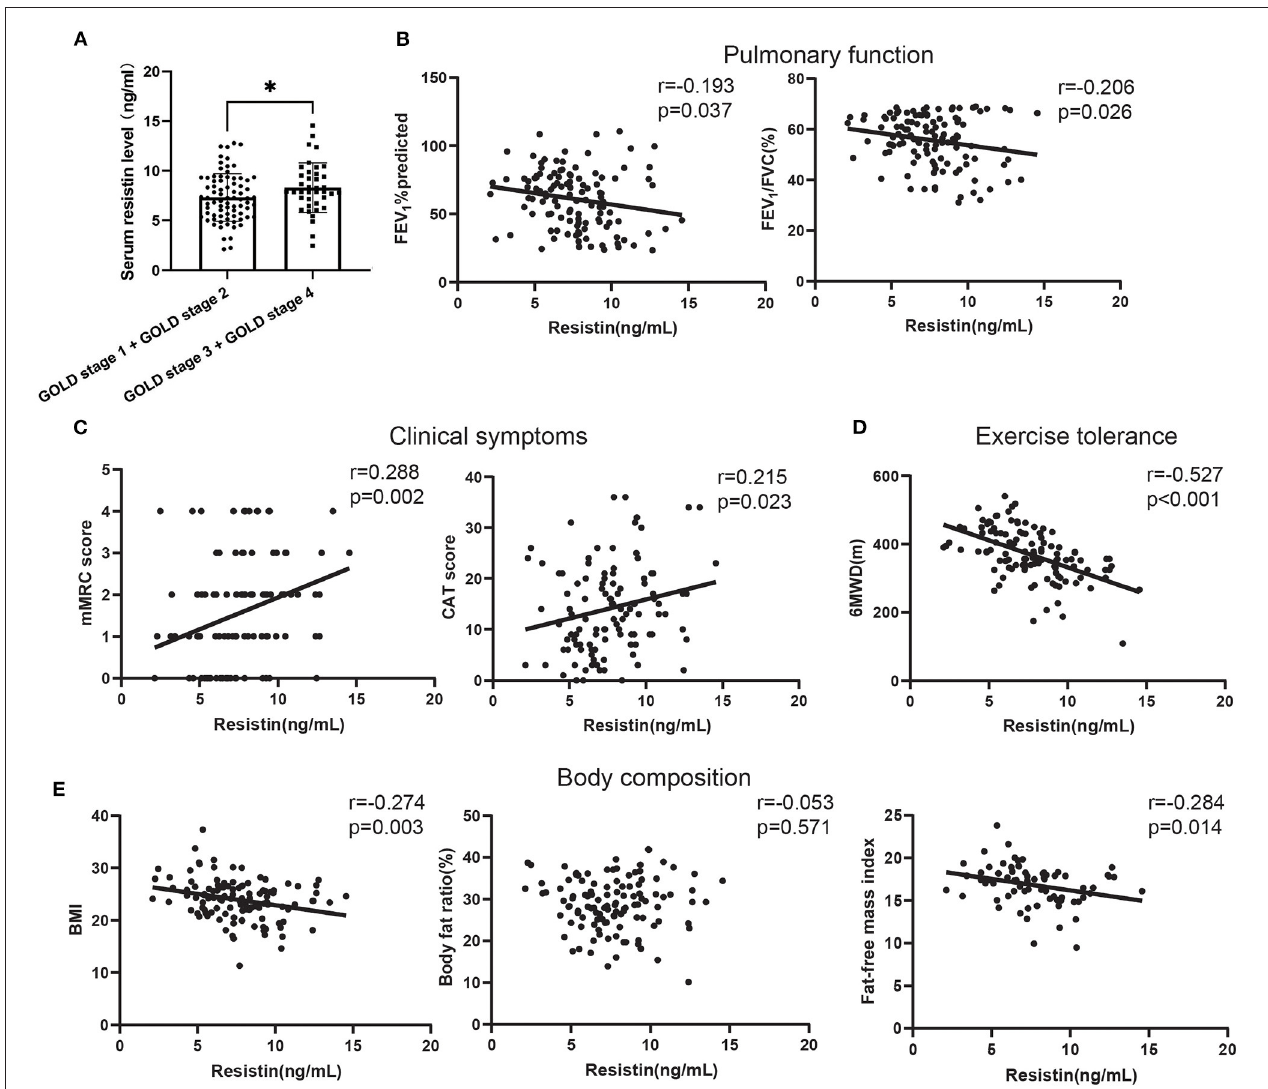
FIGURE 1 | The relationships of serum resistin levels with the clinical features of patients with COPD. (A) Difference in serum resistin level in patients with global initiative for chronic obstructive lung disease (GOLD) A and GOLD B and in patients with GOLD C and GOLD D; (B) The relationship between serum resistin level and FEV 1 %predicted, FEV 1 /FVC; (C) The relationship between serum resistin level and mMRC score, CAT score; (D) The relationship between serum resistin level and 6MWD; (E) The relationship between serum resistin level and BMI, body fat ratio, FFMI. * p < 0.05.